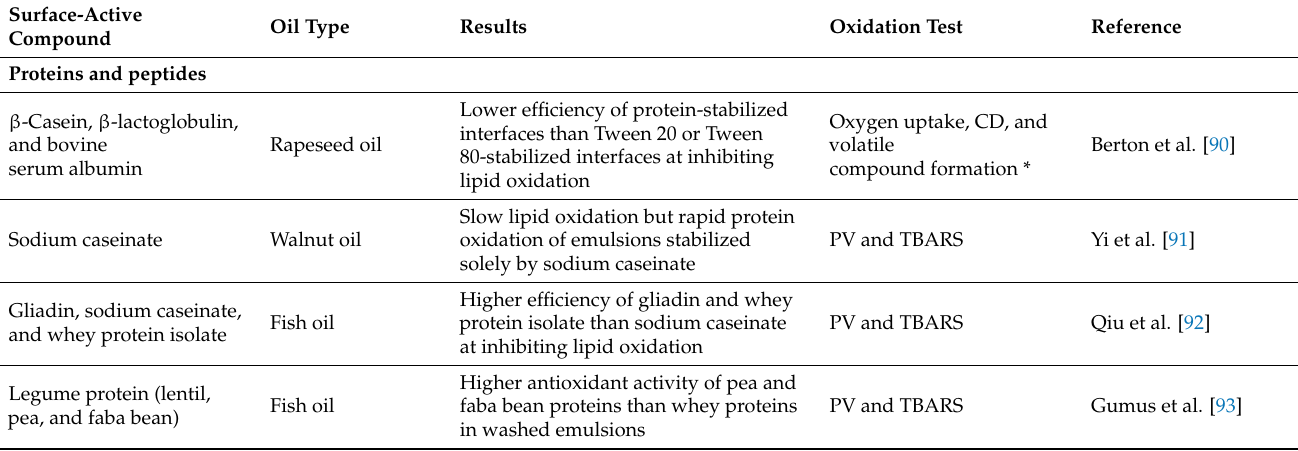
Table 4. Effects of surface-active compounds on inhibiting lipid oxidation at the interfacial region of the oil-in-water emulsions.